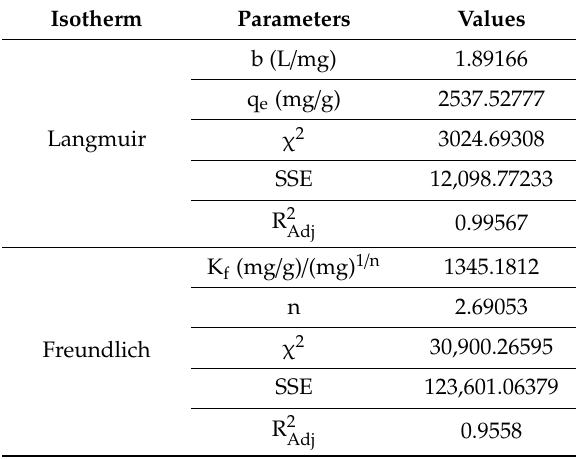
Table 7. The values of isotherm